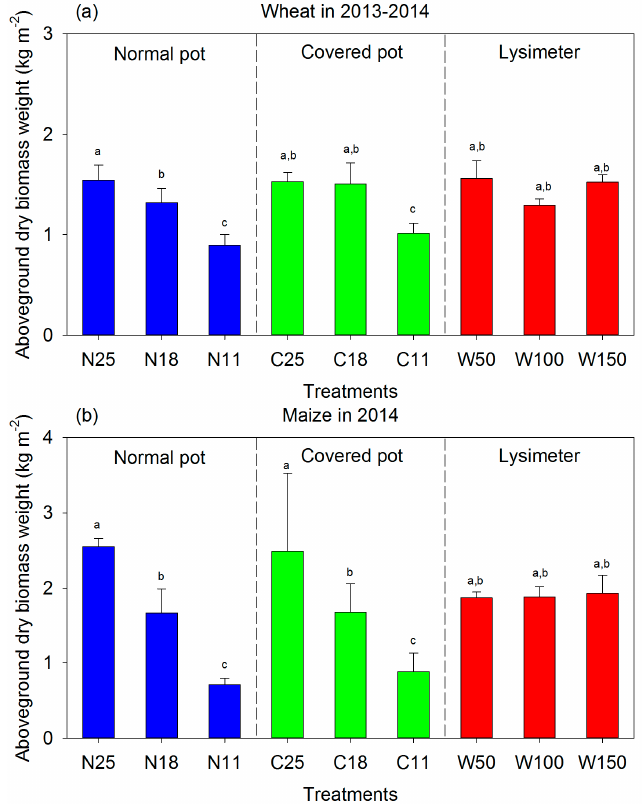
Figure 7. Aboveground dry biomass weights of ( a ) wheat and ( b ) maize per area measured during the pot and lysimeter experiments at harvest. Data for pots were corrected based on the average crop density found for the lysimeters. The three soil moisture content treatments involved 11 ± 2%, 18 ± 2%, and 25 ± 2% for pots with a crop (N11, N18, N25) and for covered pots with crops (C11, C18, C25). Three water-deficit treatments applied to lysimeters were controlled to 50 ± 15 mm (W50), 100 ± 15 mm (W100), and 150 ± 15 mm (W150), compared to field water capacity levels. Different letters (a, b, c) denote significant differences between treatments (p <